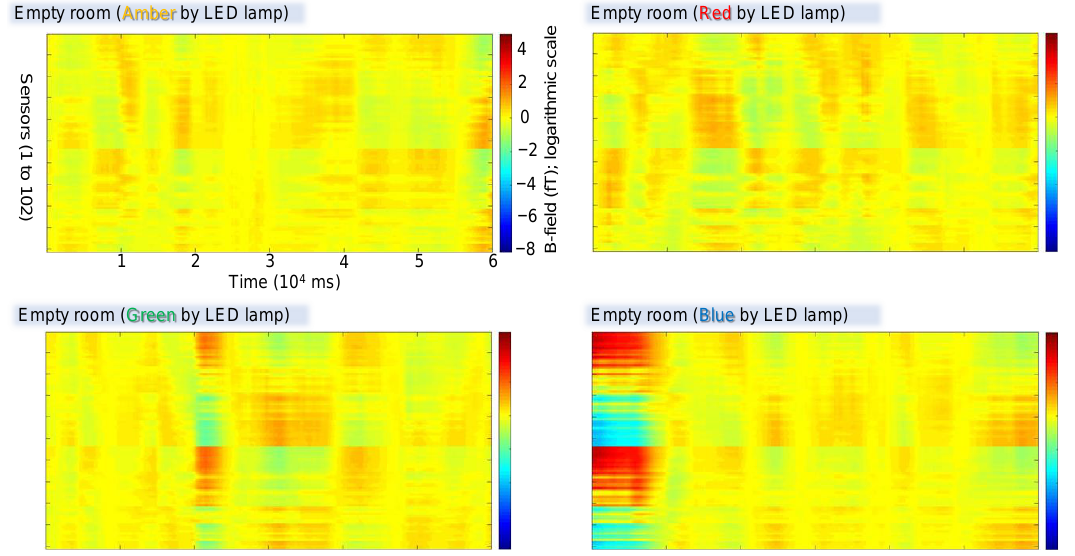
Figure 4. Magneto-encephalography (MEG) setup test with LED-lamp at different color illumination RGB+amber. Data color-maps are plotted on the same intensity scale.